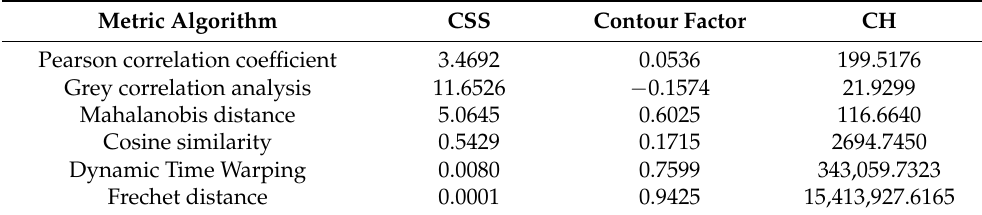
Table 2. Associated mode clusters’ component serial number name comparison